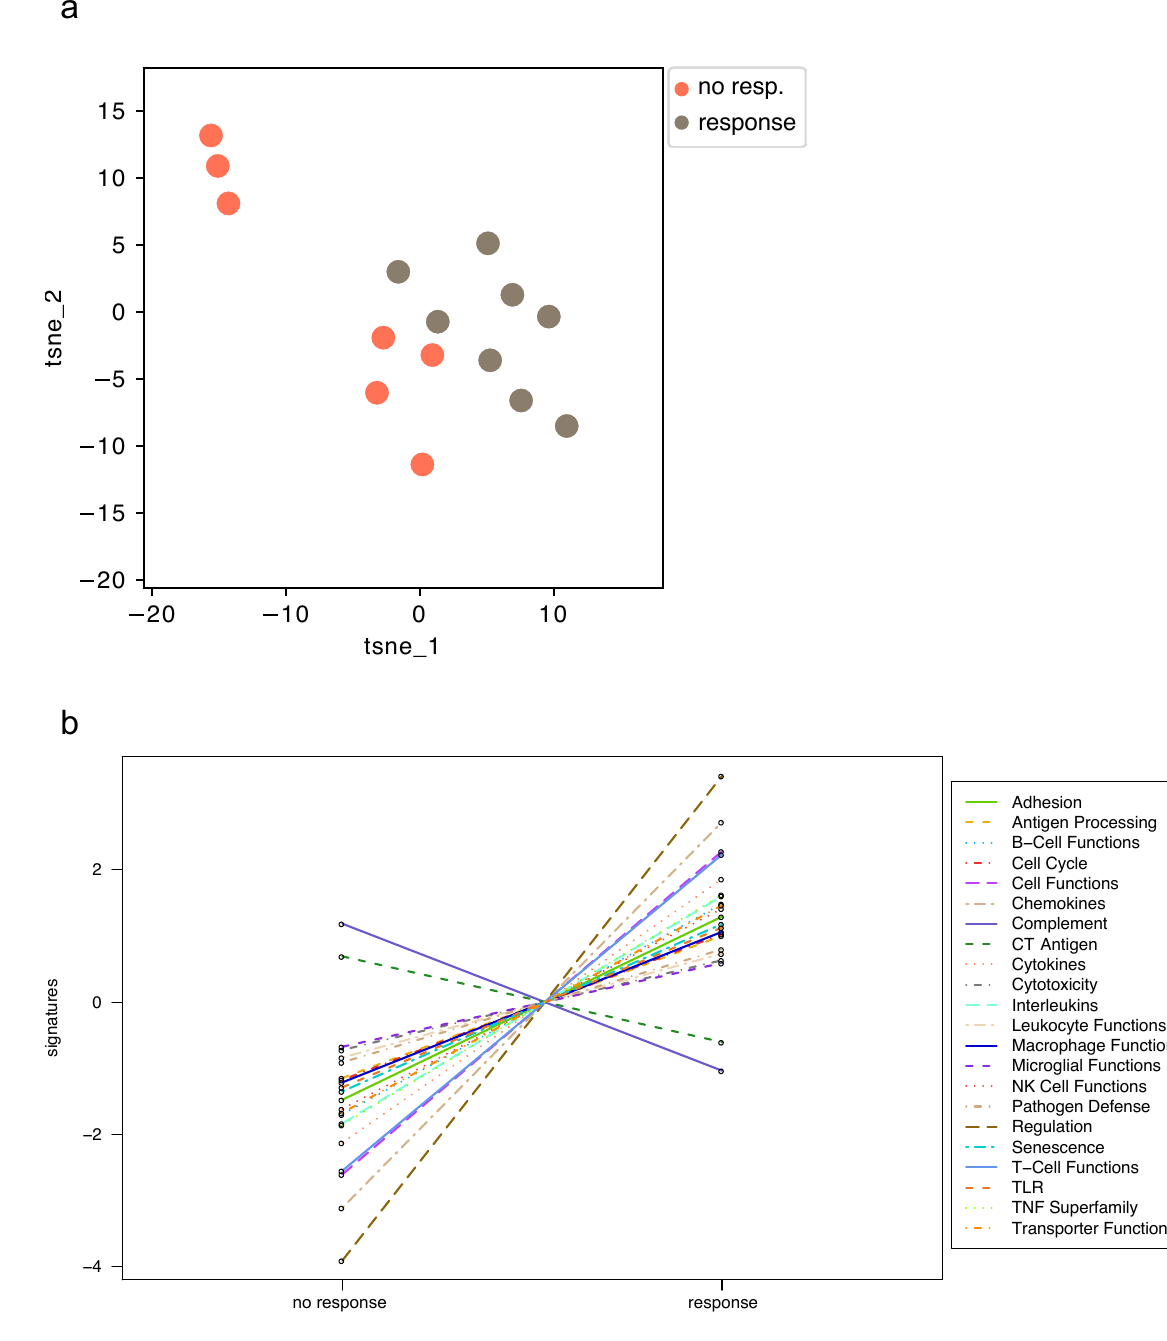
Figure 2. NanoString analysis reveals broad upregulation in immune pathway scores in TACE responders. ( a ) Unsupervised t-SNE plots of all normalized mRNA and ( b ) trend plot of pathway signatures. Abbreviations: messenger ribonucleic acid (mRNA), transarterial chemoembolization (TACE), T-distributed stochastic neighbor embedding